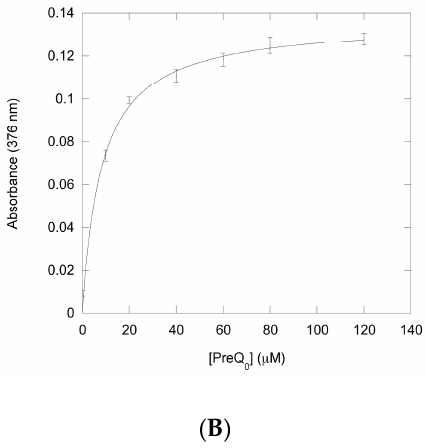
Figure 4. Ultraviolet-Visible (UV-Vis) spectroscopy of titration of a QueF-like with preQ0. ( A ) The thicker lower trace corresponds to the protein (20 µ M) absorbance prior to preQ 0 addition. The finer traces correspond, from bottom to top, to preQ0 concentrations of 10, 20, 40, 60, 80, and 120 µ M, respectively. Inset shows the region around 376 nm expanded for clarity; ( B ) Plot of absorbance at 376 nm vs. [preQ 0 ] exhibits a saturation curve.